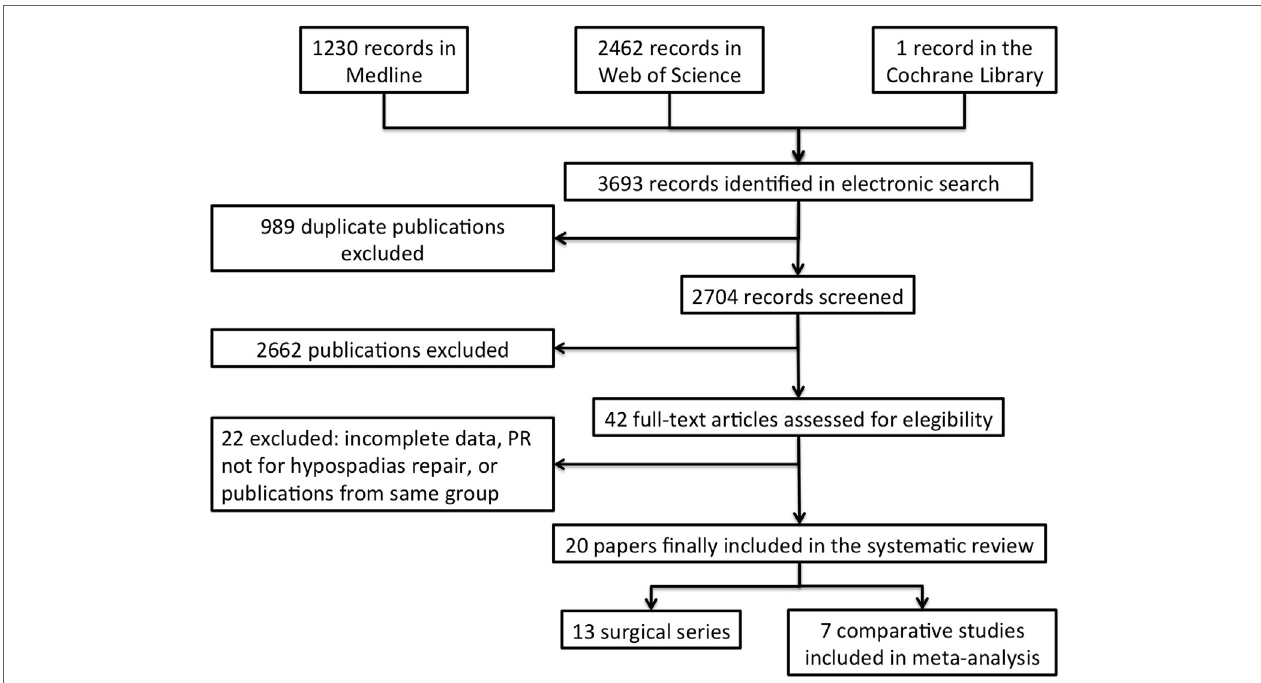
FigUre 1 | Flowchart showing the process for selection of studies included in the systematic review